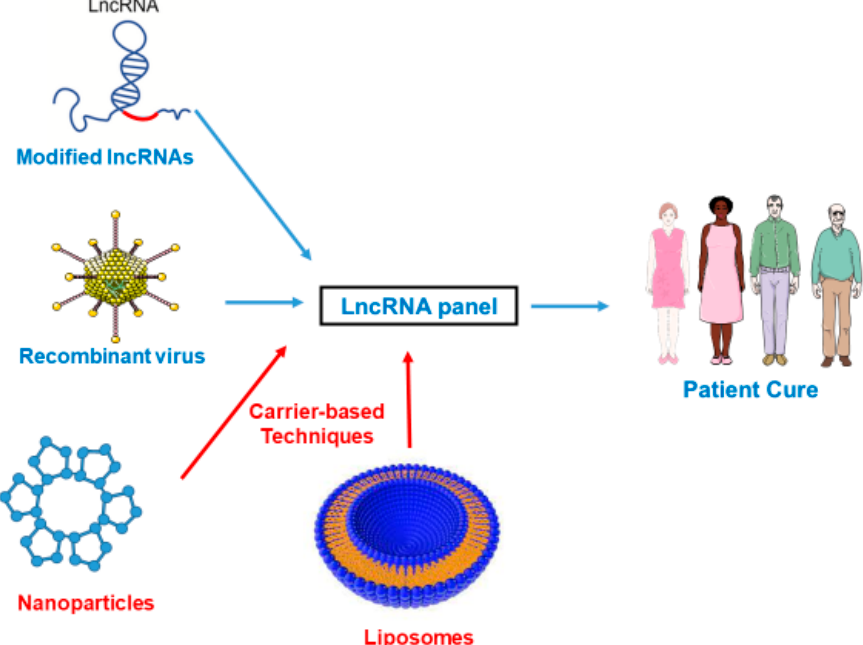
Figure 2. Innovative therapies targeting lncRNAs in the kidney.